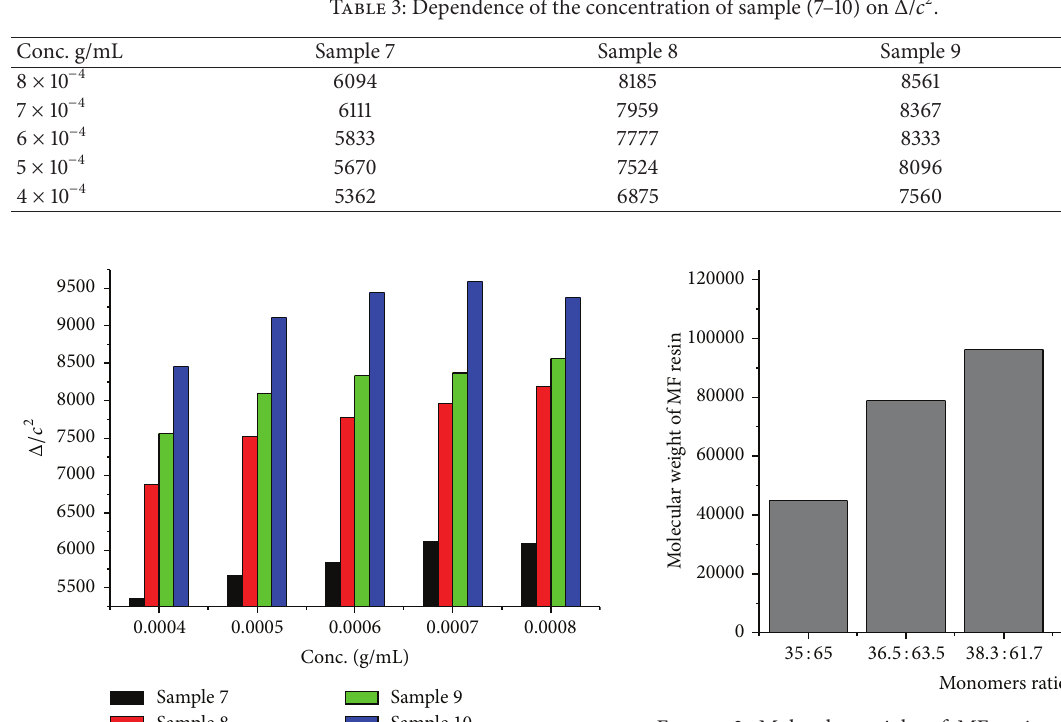
Figure 3: Molecular weight of MF resin samples (6–10) versus monomers